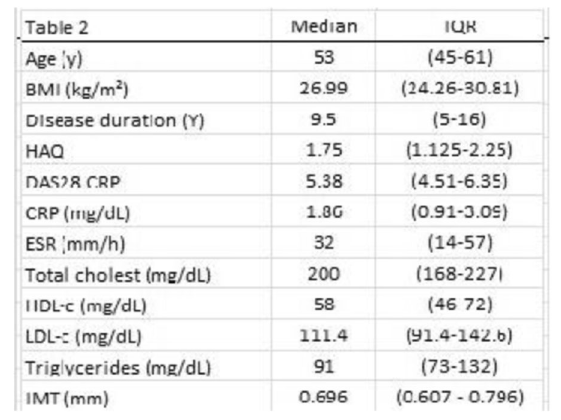
Table 2 (abstract P233). Demographic